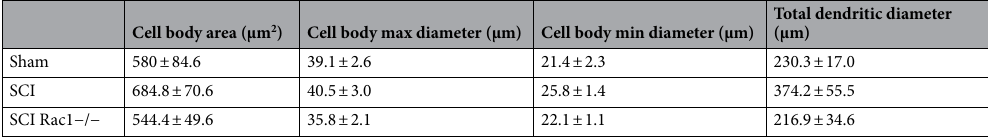
Table 1. Cell body dimensions and dendritic branch length of sampled tdTomato expressing spinal motor